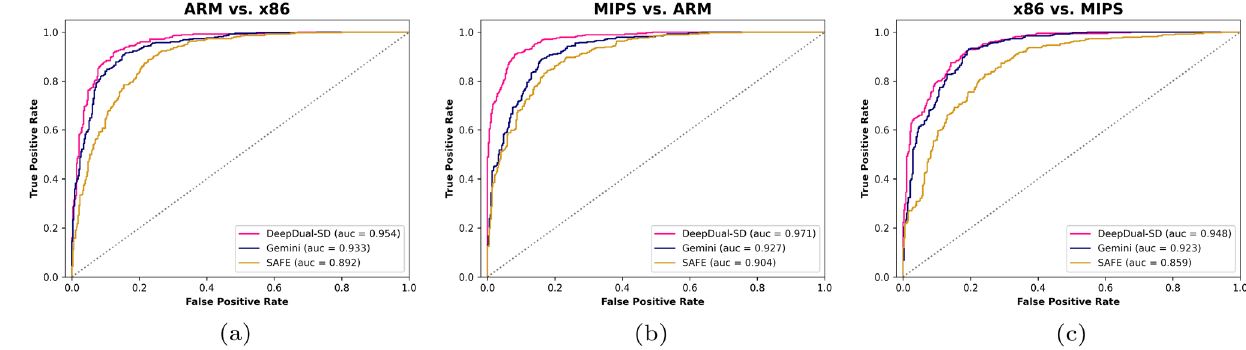
Fig. 5 ROC curves for different approach in OpenSSL binaries compiled for ARM, MIPS and